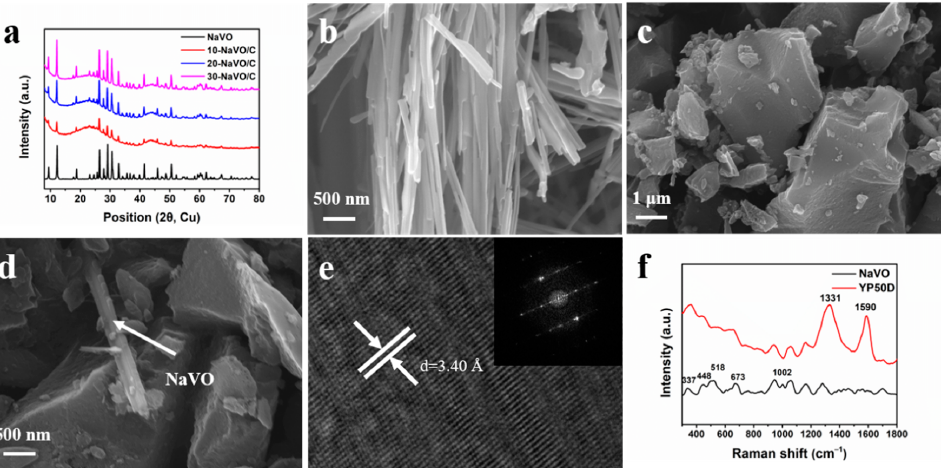
Figure 2. ( a ) XRD patterns of NaVO and the NaVO/C hybrids; ( b – d ) SEM images of NaVO nanobelts, YP50D and 10-NaVO/C; ( e ) HR-TEM micrograph of NaVO nanobelts (inset shows corresponding SAED); ( f ) Raman spectra of NaVO and YP50D.